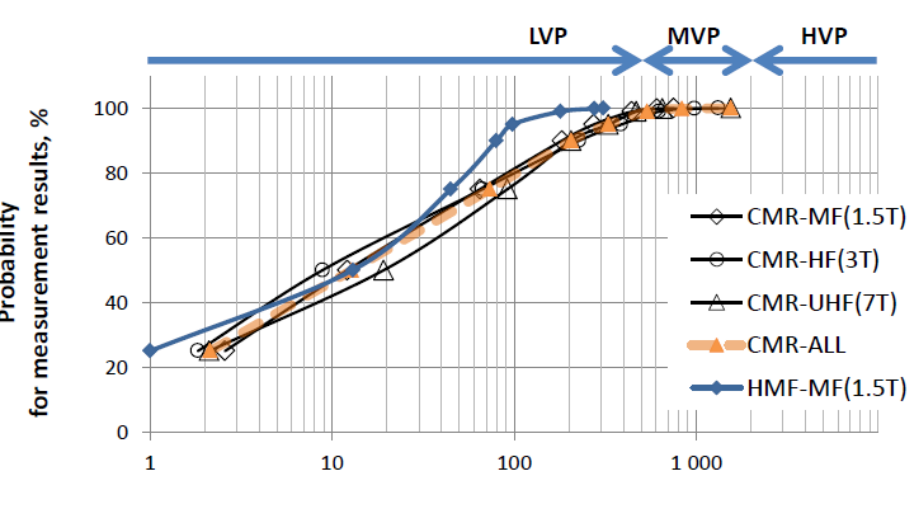
Figure 4. Distribution of the results of measurements collected by an exposimeter during the per- formance of 42 modelled CMR and 13 real head MRI radiographer exposure events (REEs). Static exposure to the magnetic field near MRI magnets, SEmf in mT, and a relevant evaluation of the probability of vertigo perception due to such exposure (LVP, MVP and HVP as shown in Table 1 regarding a peak value over the shift,